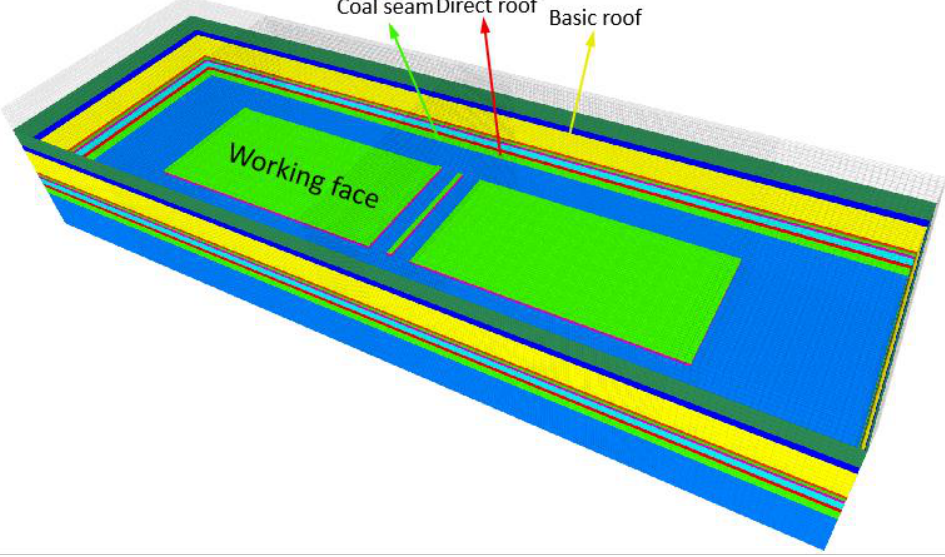
Figure 5. Numerical simulation model of overburden in a stope.